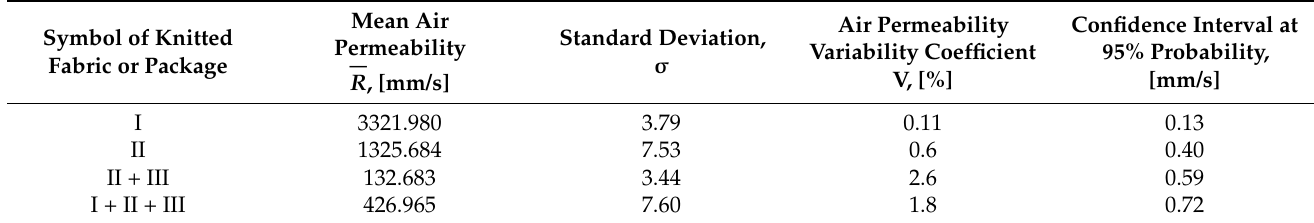
Table 5. A summary of the air permeability results according to the EN ISO 9237:1995 standard and the patented method for the spacer knitted fabrics.